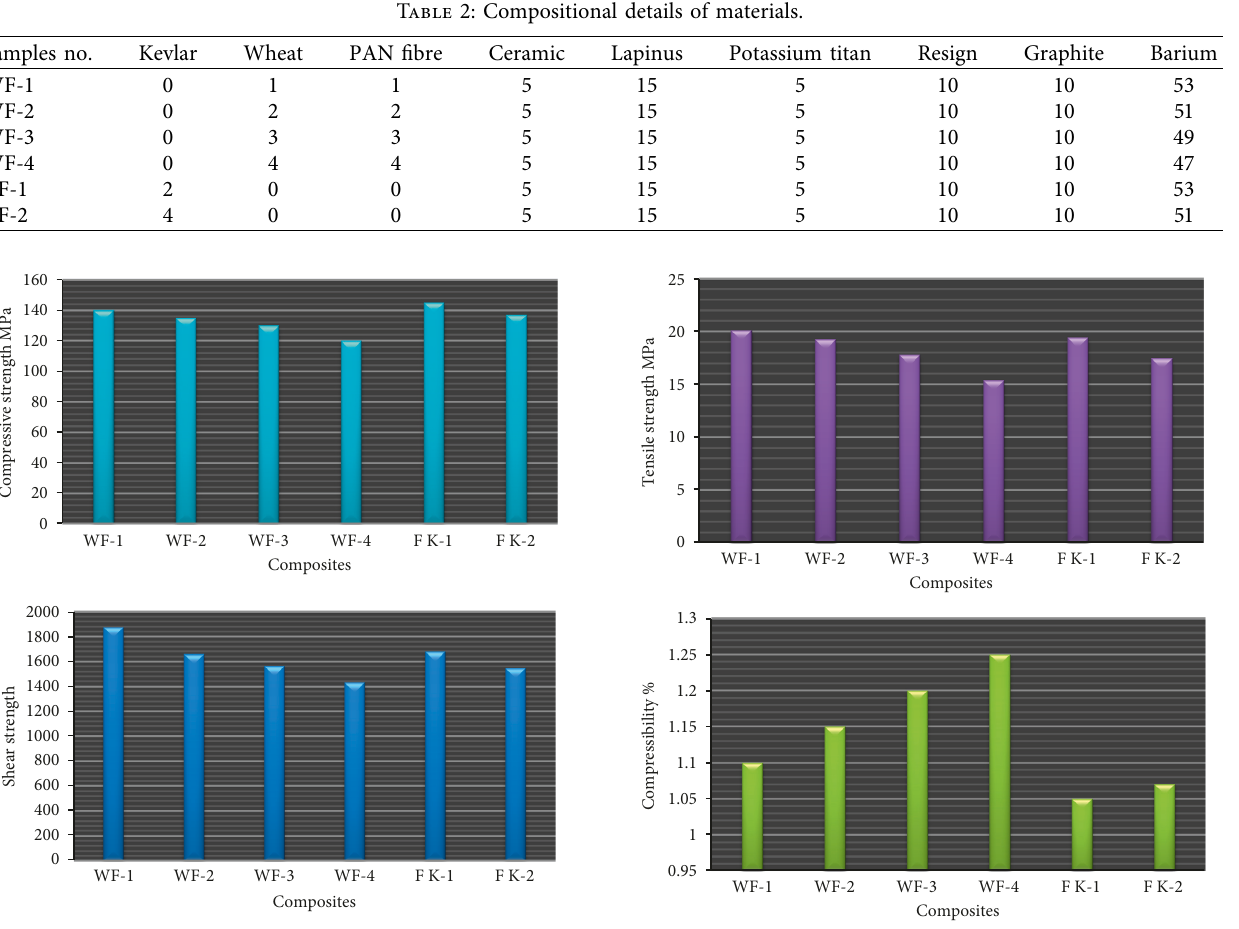
Figure 1: Compressive strength and shear strength of newly de- veloped composites.